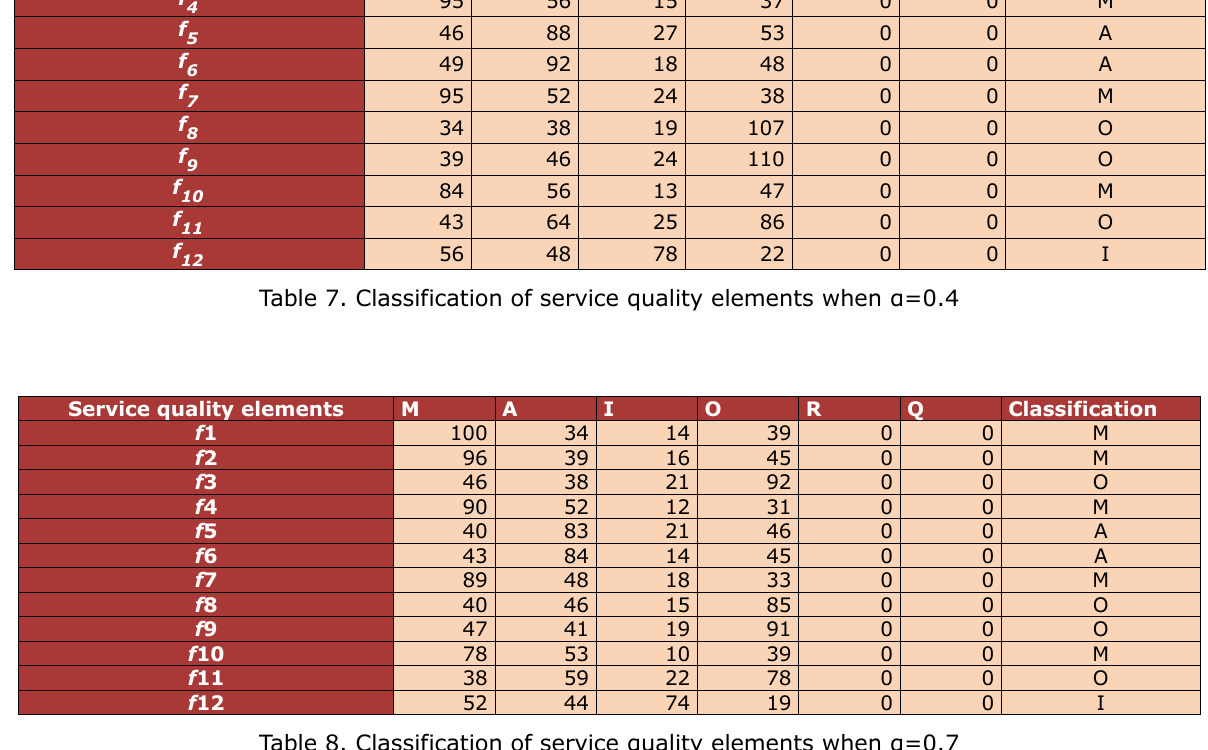
Table 8. Classification of service quality elements when